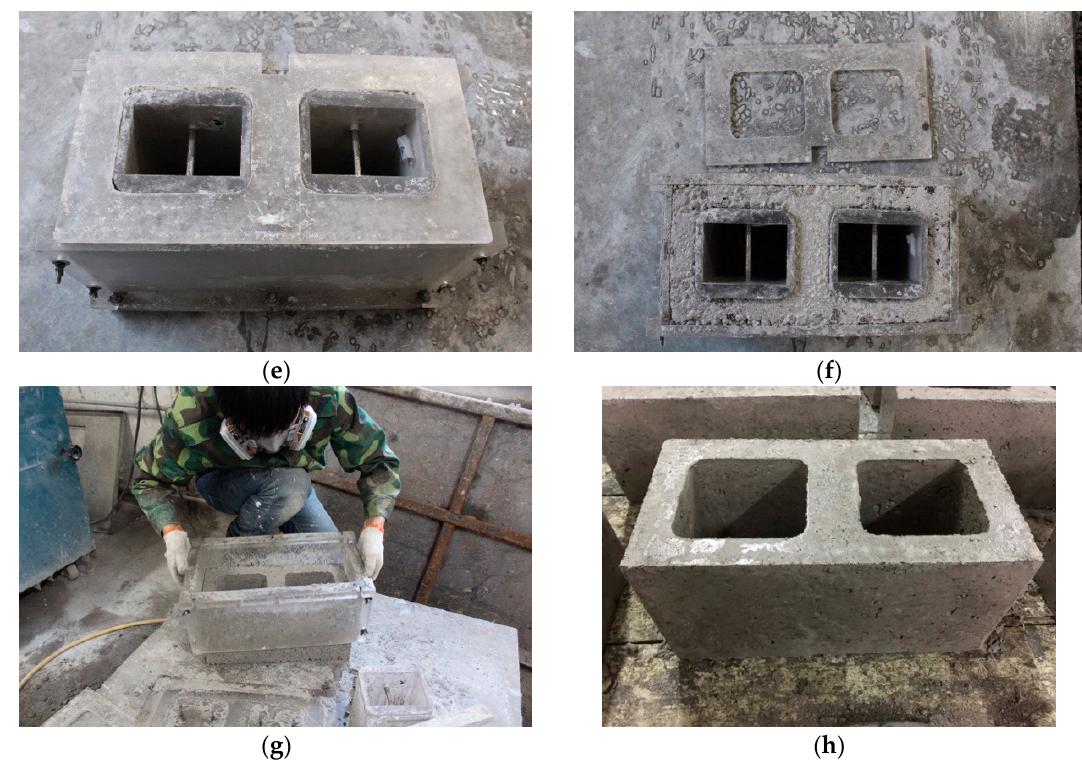
Figure 5. Preparation of alkali-activated slag concrete hollow block (AASCHB) specimens: ( a ) homemade plexiglass mold; ( b ) fresh concrete; ( c ) molding; ( d ) mechanical shaking; ( e ) forming; ( f ) demolding process 1; ( g ) demolding process 2; ( h ) completed AASCHB.